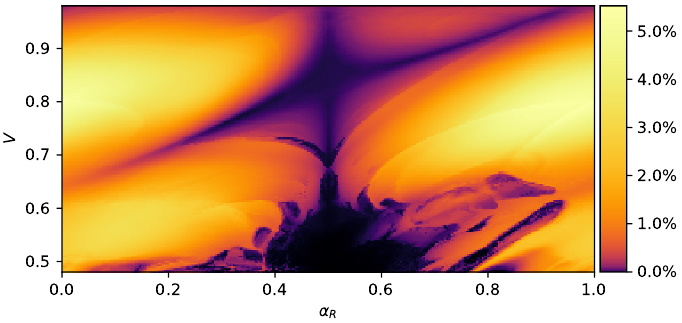
Figure 33 . Fraction of the total energy of the initial con(cid:12)guration carried out by the radiation as a function of the input speed V and phase of right input oscillon (cid:11) R while holding (cid:12)xed the right input oscillon’s phase (cid:11) R =